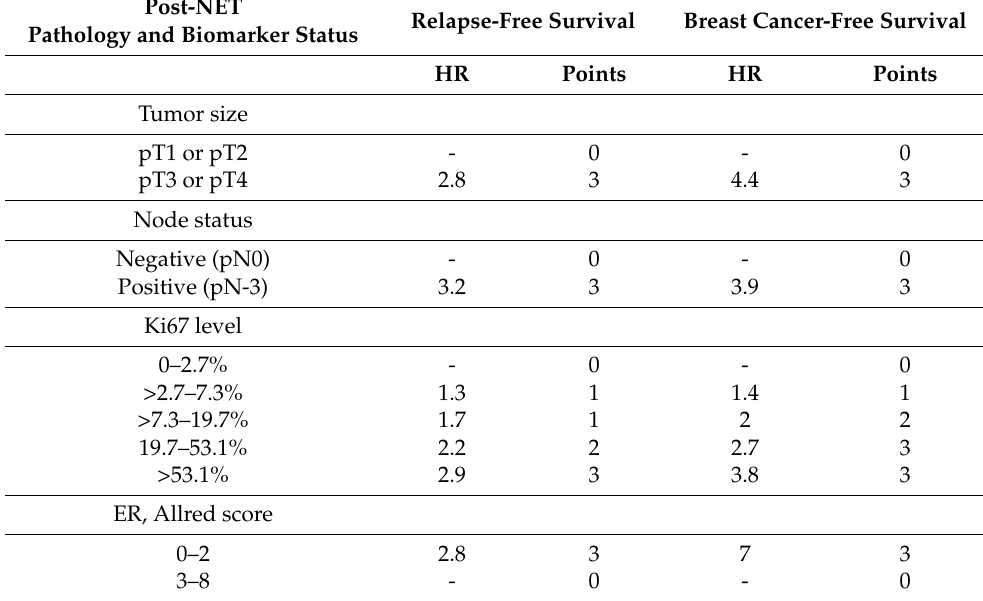
Table 6. Preoperative endocrine prognostic